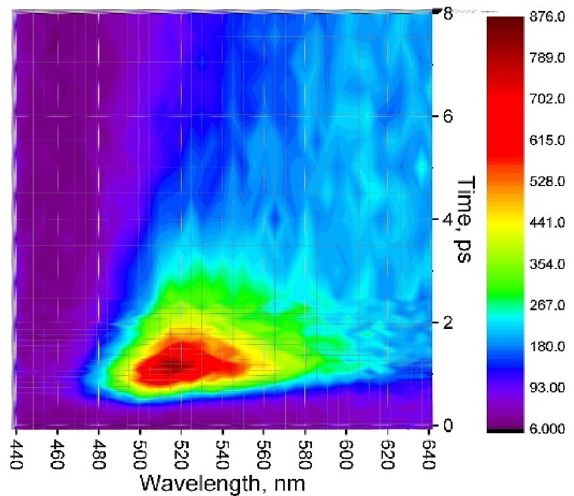
Figure 3. Up-converted fluorescence map of perylene film, λ ex = 400 nm.